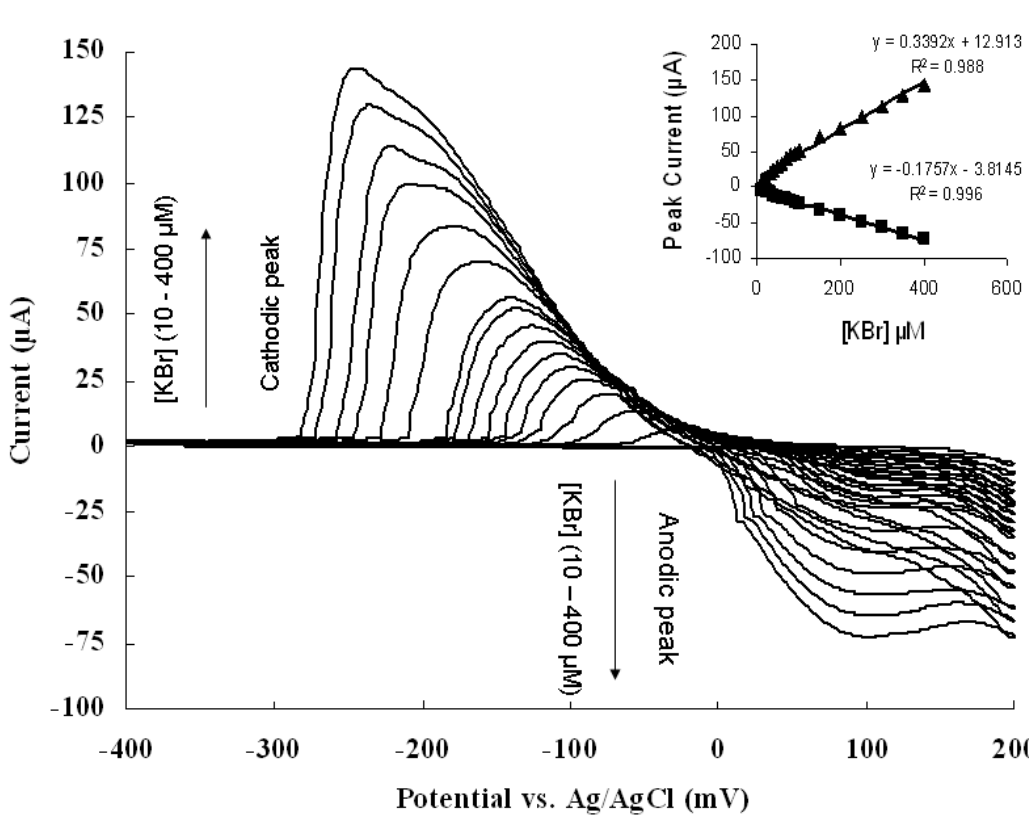
Figure 1 . Cyclic voltammograms of silver electrode were obtained in KNO solution having different 3 concentrations of KBr. From inner to outer: 10; 20; 30; 40; 50; 60, 70; 80; 90; 100; 150; 200; 250; 300; 350 and 400 µM of KBr (scan rate: 100 mV s -1